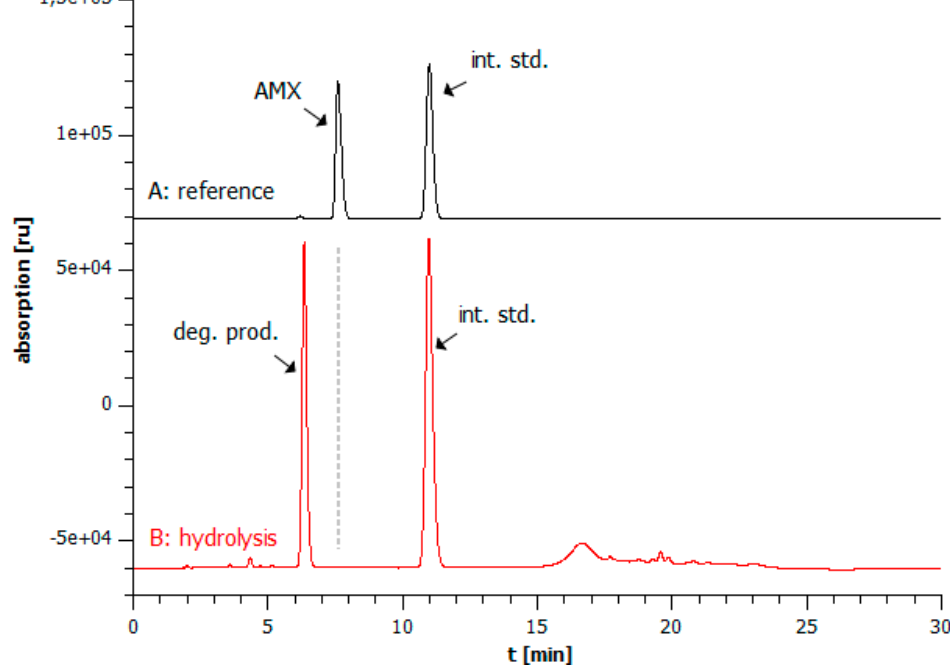
Figure 2. ( A ). Reference HPLC chromatogram of prepared dry suspension of amoxicillin (AMX) with paracetamol as internal standard (int.std.). Retention times rt AMX = 7.4 min, rt int. std. = 11.0